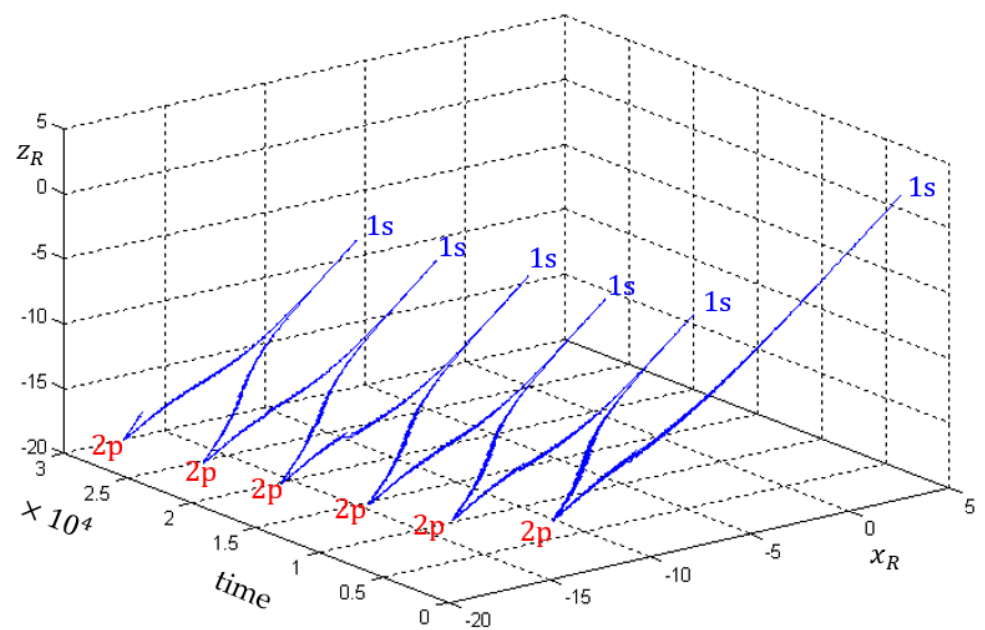
Figure 𝟕 . The time evolution of the 1s – 2p transition trajectory in the real x - z plane. Figure 7. The time evolution of the 1s–2p transition trajectory in the real x - z plane. Photonics 2022 , 9 , x FOR PEER REVIEW